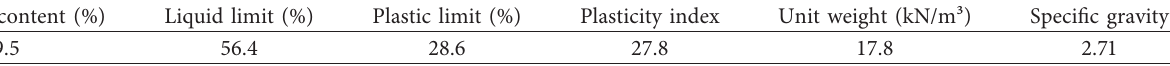
Table 1: Basic properties of Lianyungang clay.